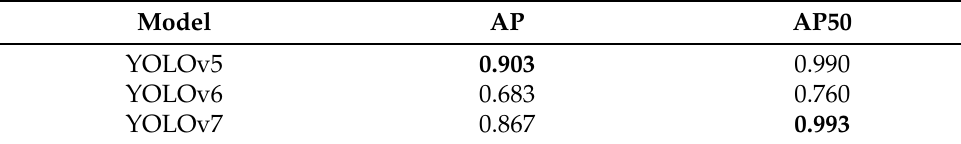
Table 1. Detection performance of different YOLO frameworks.